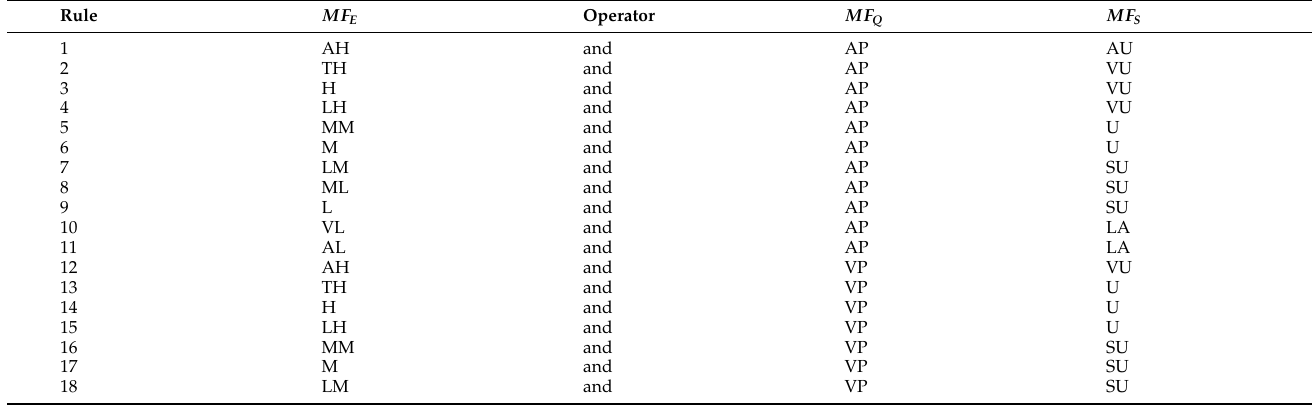
Figure 2. The S values range as obtained using the Mamdani Fuzzy Inference System. Table 2. The Fuzzy rule (or knowledge)